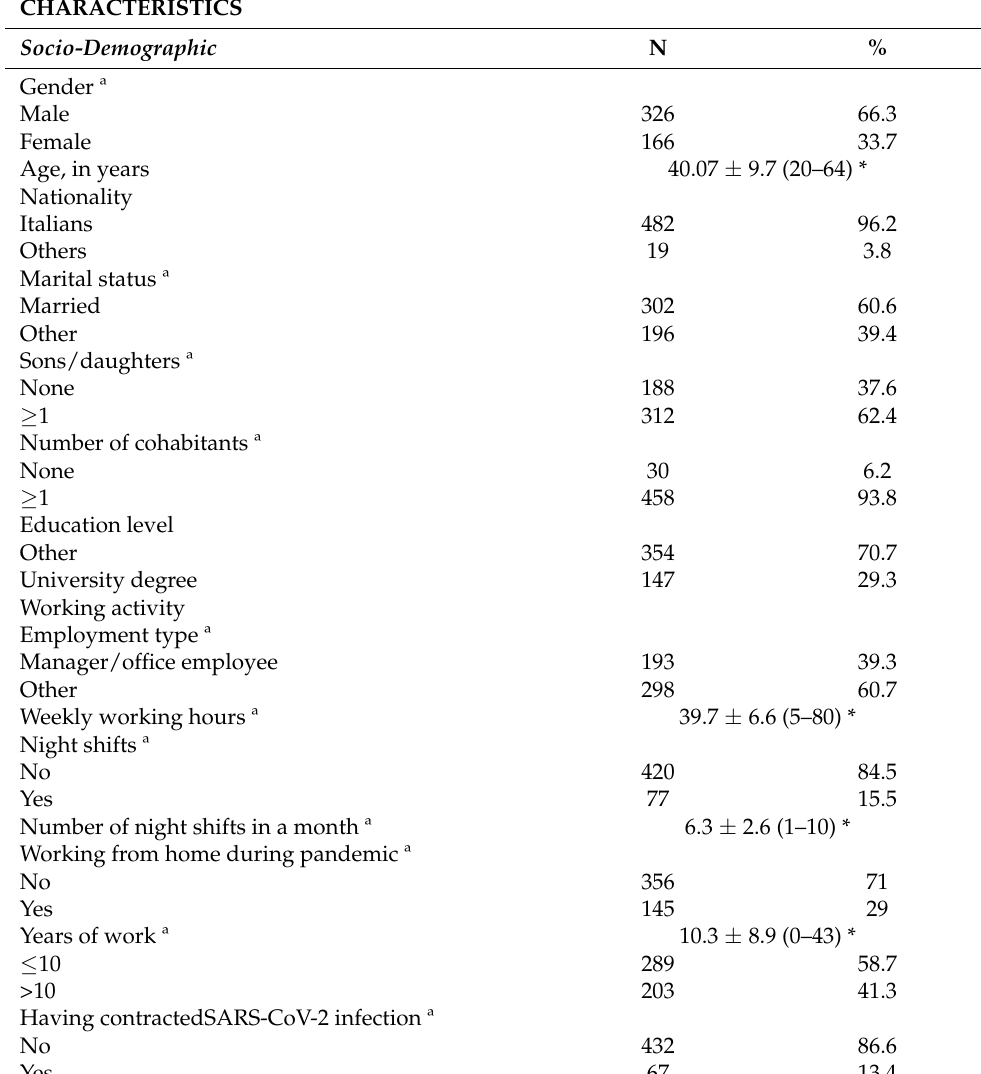
Table 1. Socio-demographic and anamnestic characteristics of the study population (N =